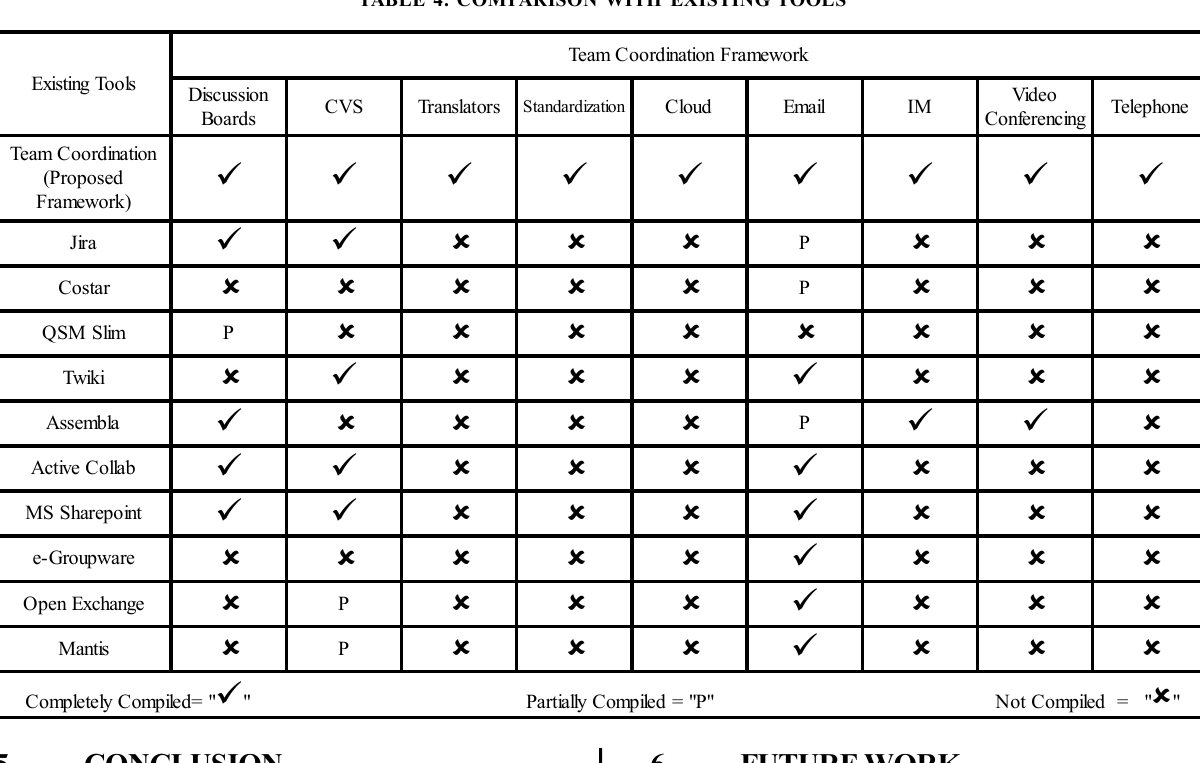
TABLE 4. COMPARISON WITH EXISTING